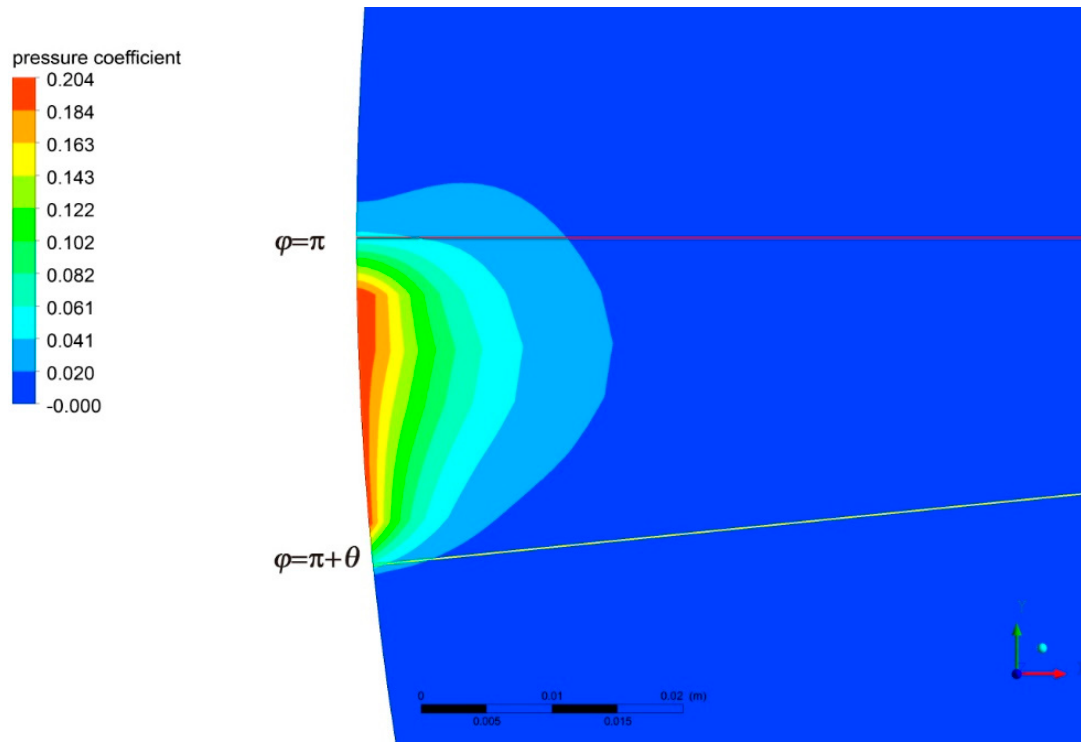
Figure 13. Distribution of mass flow rate for C w = 10,137, E = 0.2, θ = 0.1 at r / b = 1.